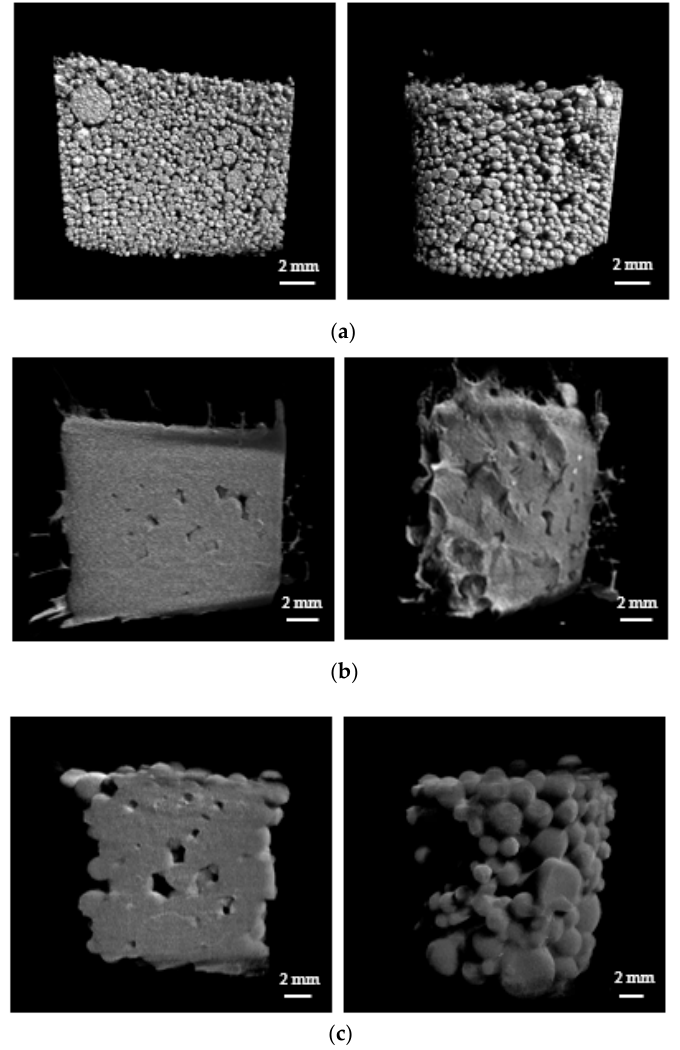
Figure 4. Micro-CT analysis (left: cross-section region, right: outer region) on the swelling properties of the packed SAP spheres. Micro-CT images of ( a ) dried SAPs ( b ) swollen SAPs and ( c ) swollen AgNP-SAPs packed in the mold.